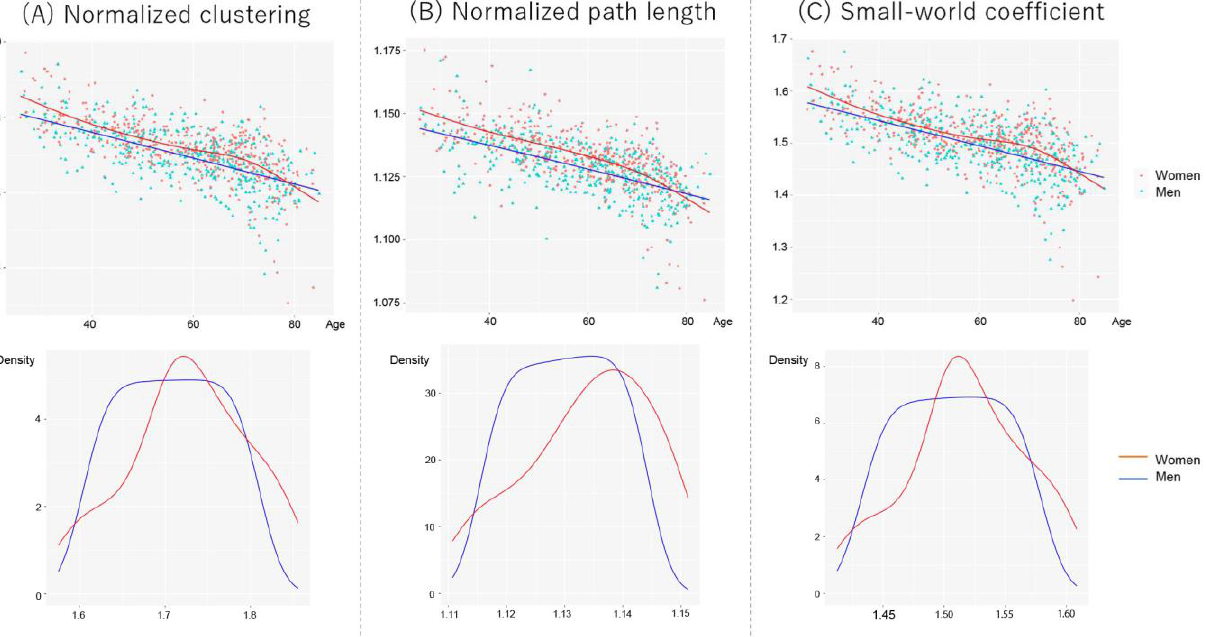
Table 1. Demographic characteristics of the participants. 232